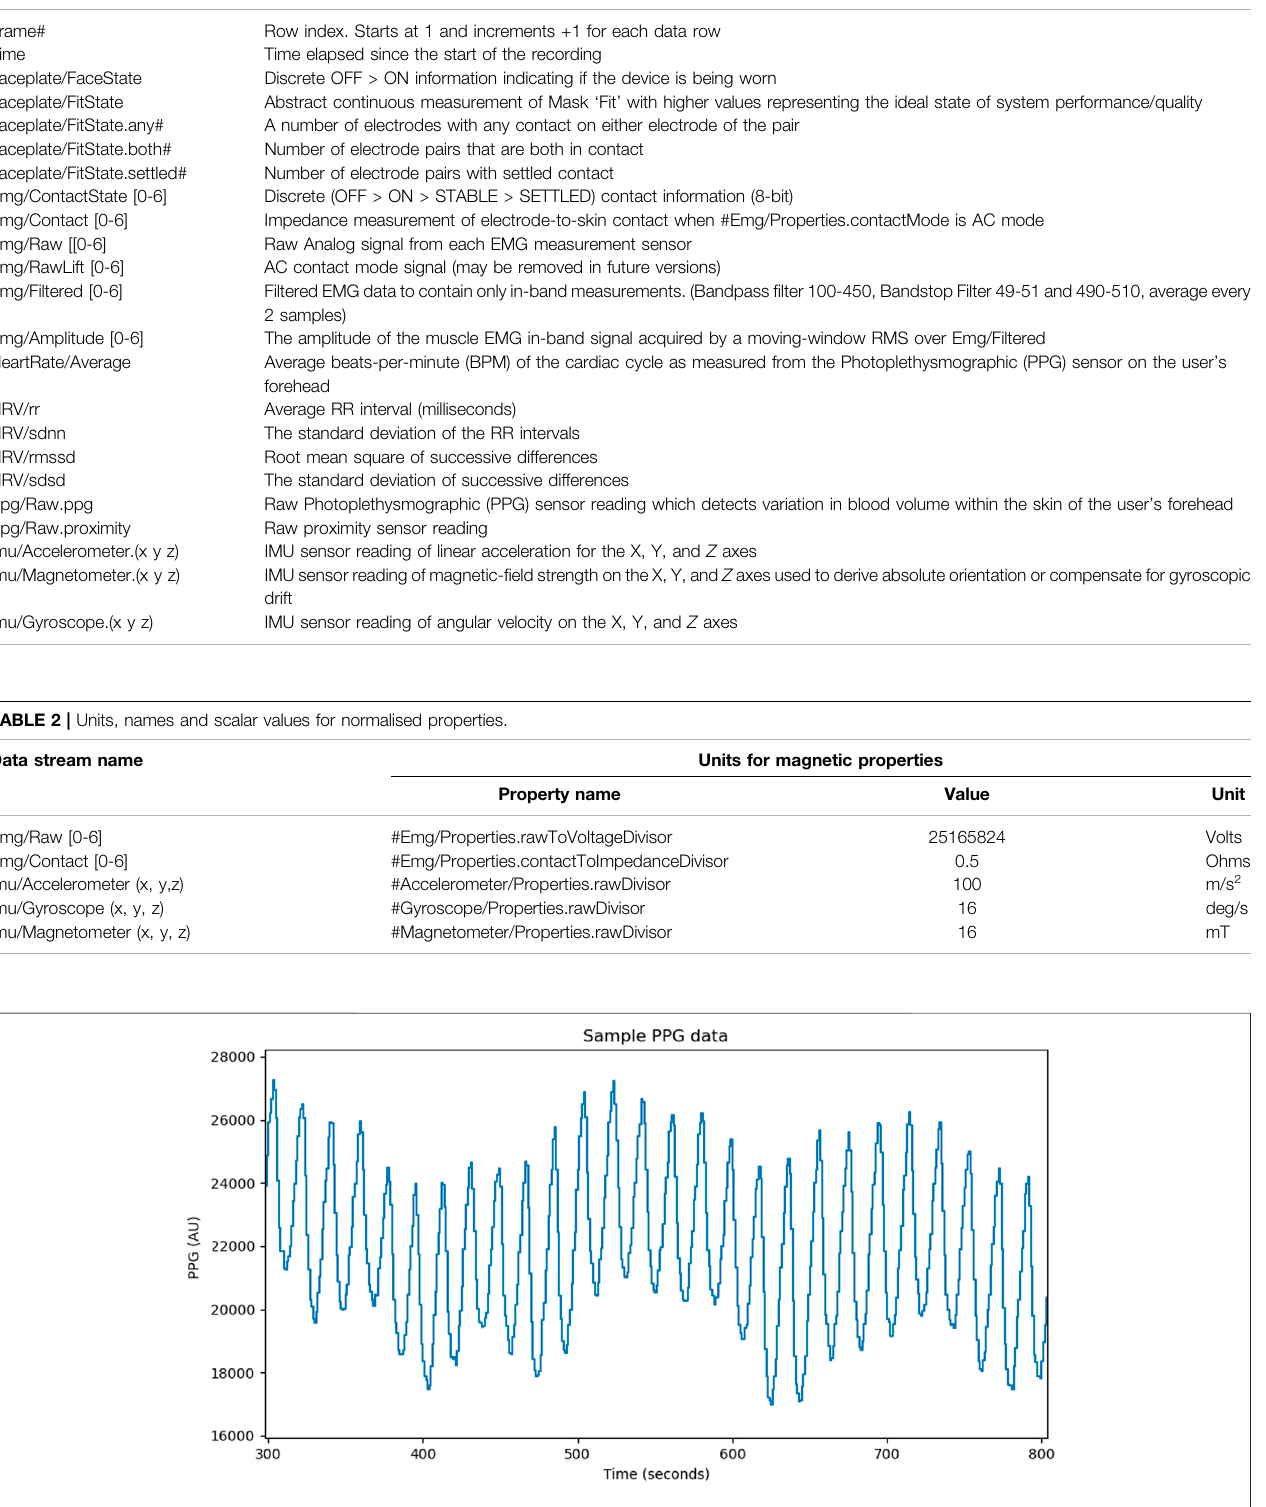
FIGURE 11 | Sample raw PPG signal collected with visible peaks and morphology used for further processing and extraction of features such as heart rate, heart rate variability, breathing rate.